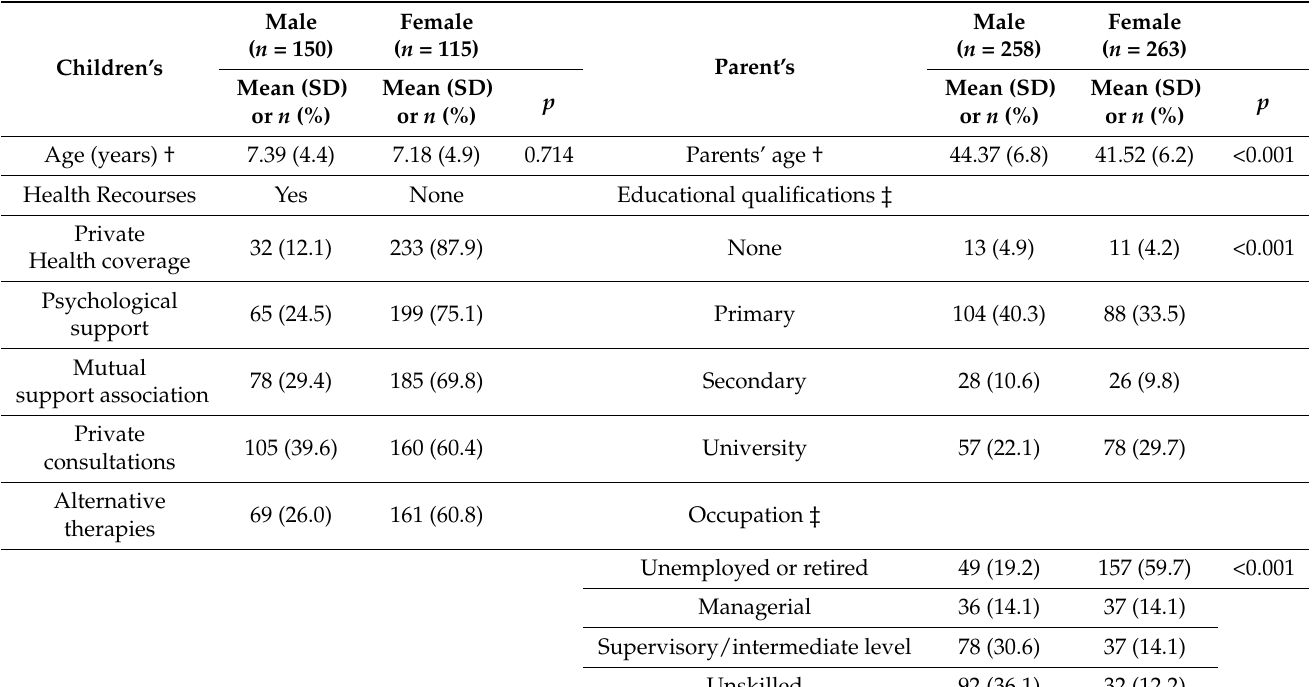
Table 1. Characteristics of the